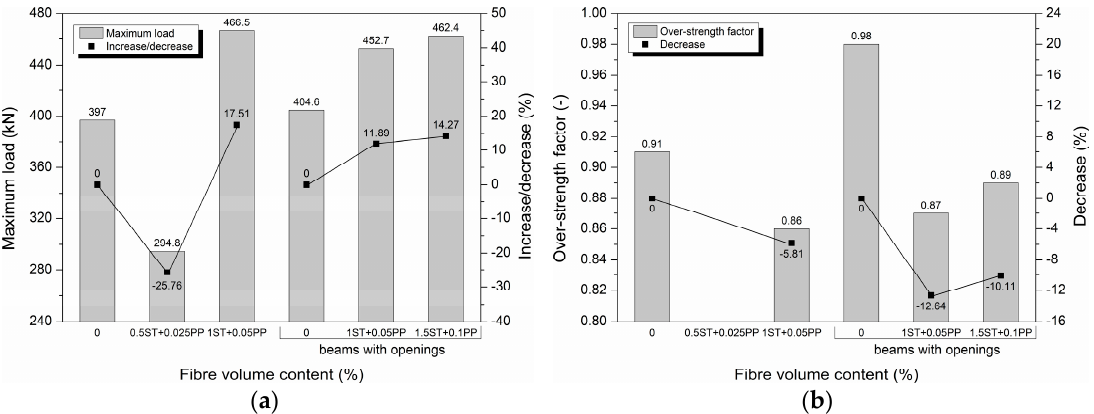
Figure 8. Comparison of beam ( a ) maximum load and ( b ) over-strength factor.